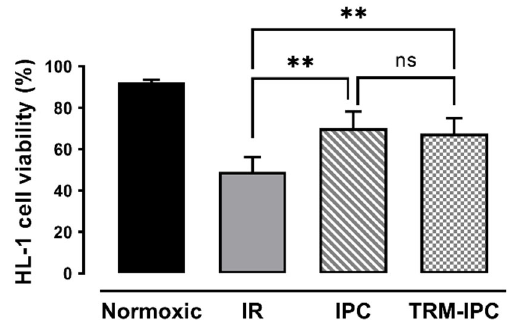
Figure 2. Protocol 1: Ischemic conditioning attenuates HL-1 cardiomyocyte death. HL-1 cell viability, assessed by Trypan blue staining, in IPC, TRM-IPC, simulated IR and normoxic groups. Both IPC and TRM-IPC were cytoprotective: ** p < 0.01 versus simulated IR; ns = not significant; n = 10 replicates per group. IR = simulated ischemia-reoxygenation, IPC = ischemic preconditioning, TRM-IPC = transfer of IPC ‘reperfusate’ medium.